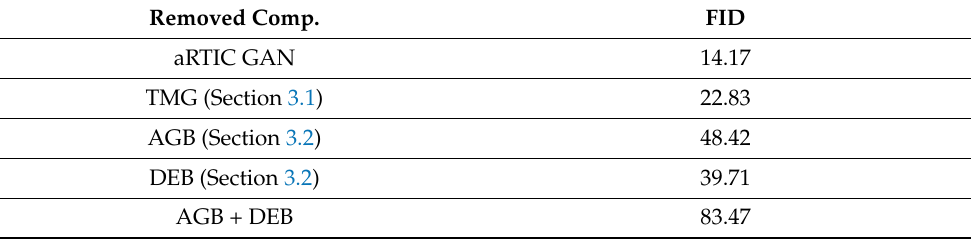
Table 6. Here are presented the FID scores retrieved when the indicated component is removed from the complete model. Removed